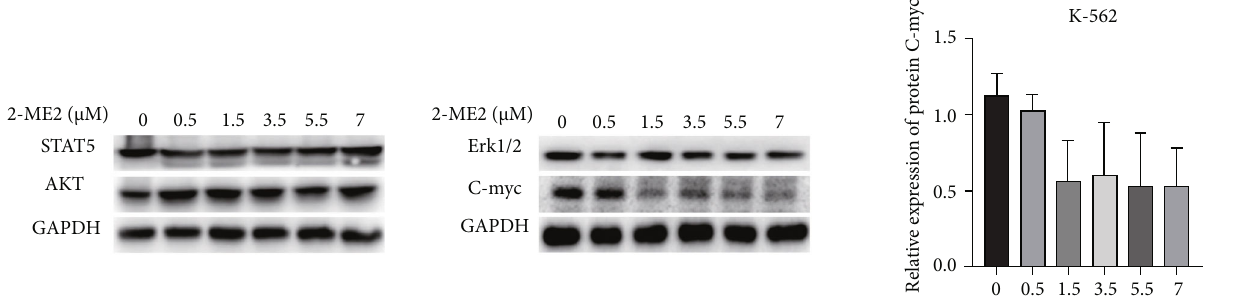
Figure 7: The expression of related pathways in K-562 cells treated with 2-ME2 for 24 h detected by Western